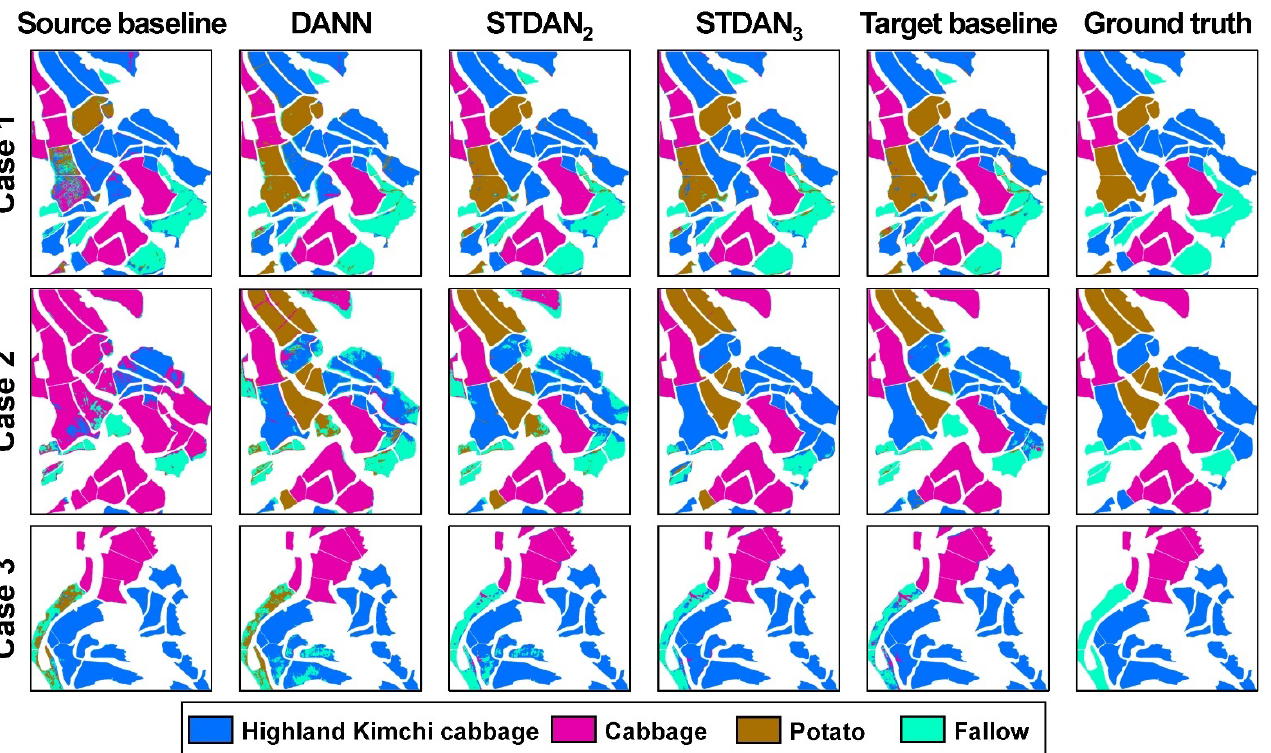
Figure 10. The five classification results for cases 1, 2, and 3 as well as the ground truth data in Gangwon.